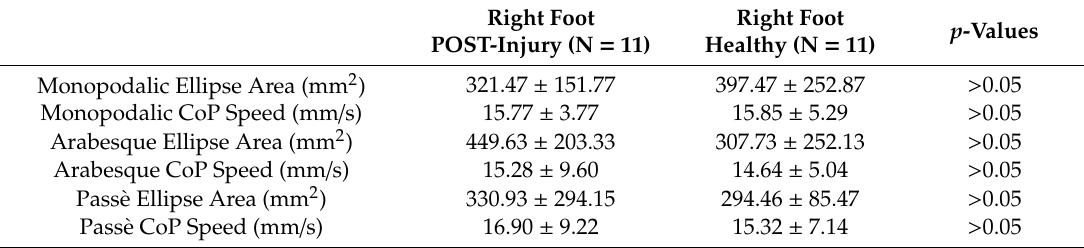
Table 6. Comparison between right foot of pathological and healthy subjects. Mean delta values (di ff erence between open and closed eyes) of stabilometric